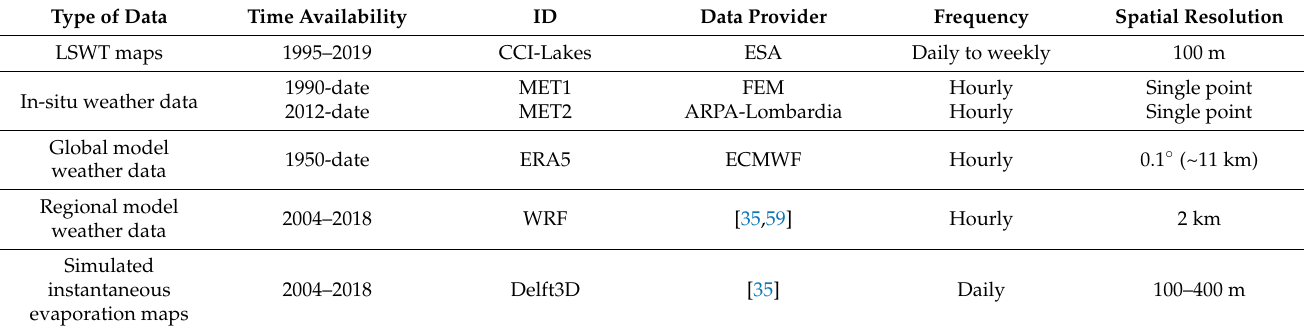
Table 2. Summary of data used in this study from in-situ, remote sensing, and numerical